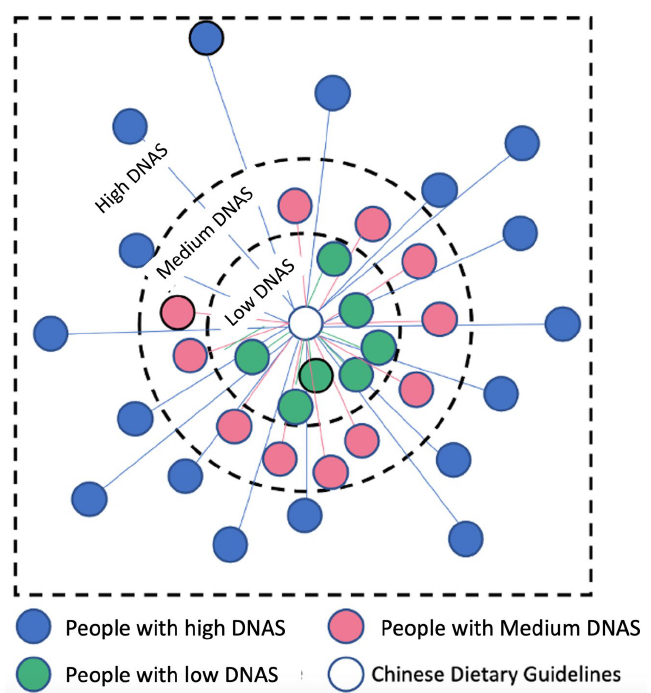
Figure A2. The schematic of the classification of the population according to Diet Adherence Score category. The central circle represents the Chinese Dietary Guideline (CDG). The surrounding dots represent people in the sampled population. The distance from each individual to the CDG is the distance in a 10-dimensional space from each individual’s intake of 10 food groups to the median of the intake range specified in the CDG.